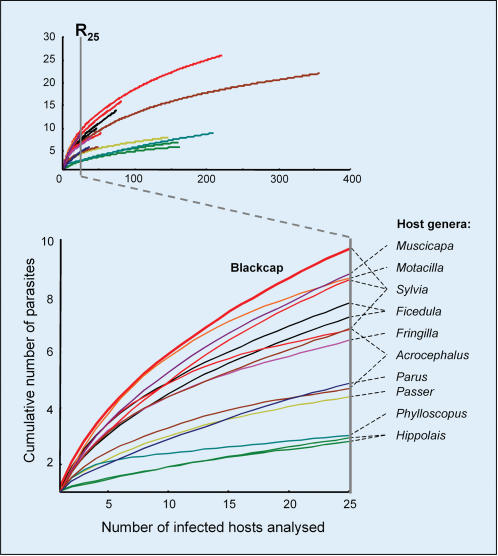
Variation in richness of malaria parasites among different bird host species. The curves represent parasite cumulative richness in 15 passerine species with more than 25 scored parasite infections, belonging to 10 bird genera (represented in different colours, see details in Table 1). The curves provide a standard estimate of parasite richness (R25) for each species, given by the number of parasites accumulated after analysing 25 infected individuals. The small graph shows the curves of parasite accumulation including all infections scored in each species (n = 26-353), crossed by a dotted line at R25. Blackcaps show the highest richness of malaria parasites in both graphs.